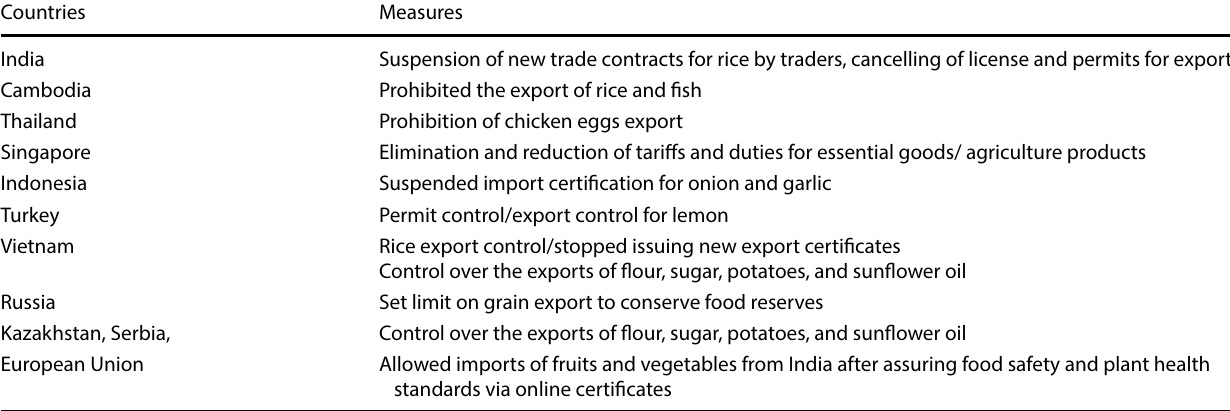
Table 3 Trading strategies implemented by world countries to limit pandemic outbreaks and guarantee local food security Source: [55, 81] Countries